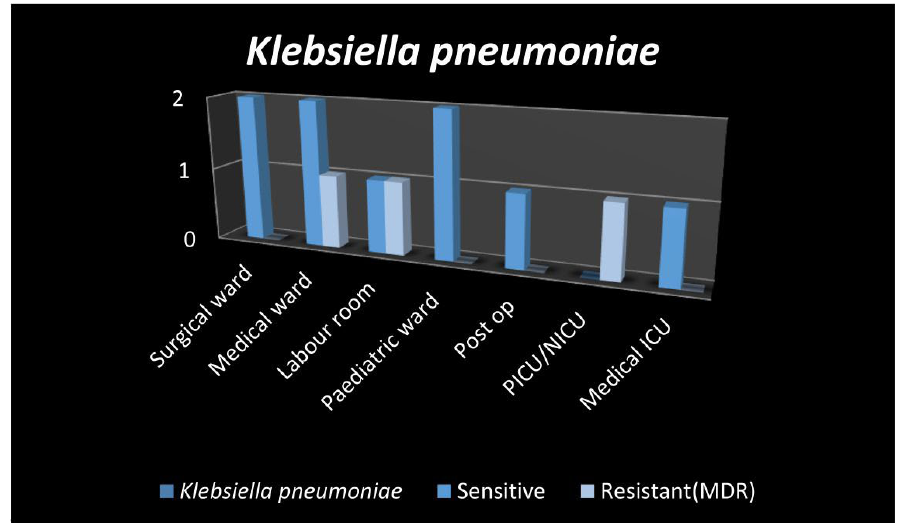
Fig 3. The sensitive strains and resistant strains of Klebsiella pneumonia